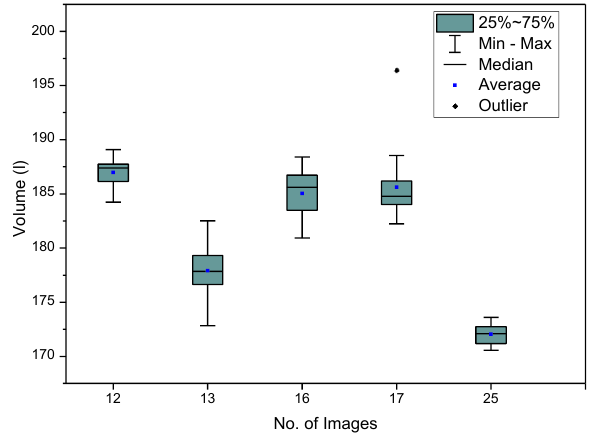
Figure 8: Automatically calculated waste bin volume in relation to the number of images 4.2 Reliability and accuracy